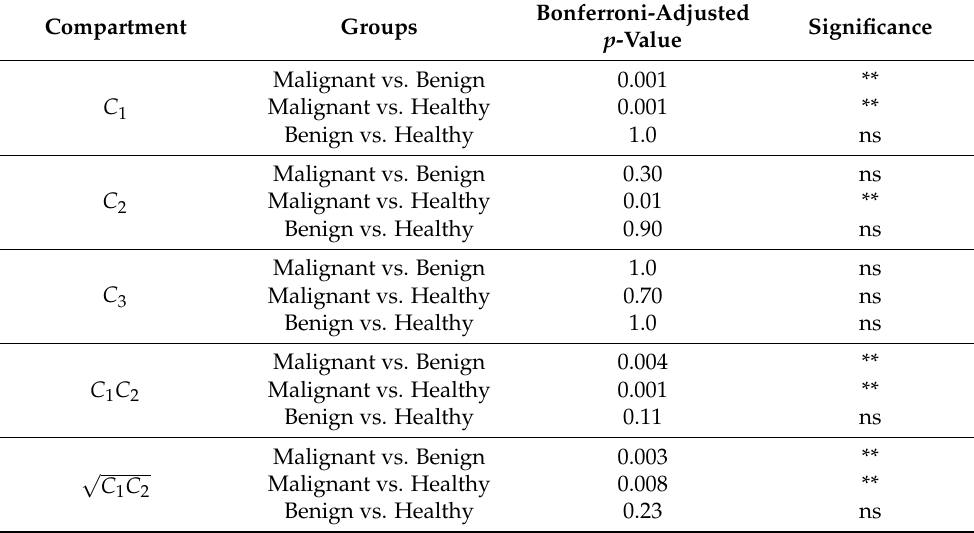
Table 3. Pairwise comparisons of tissue type per compartment (ns: p > 0.05; **: p < 0.01).